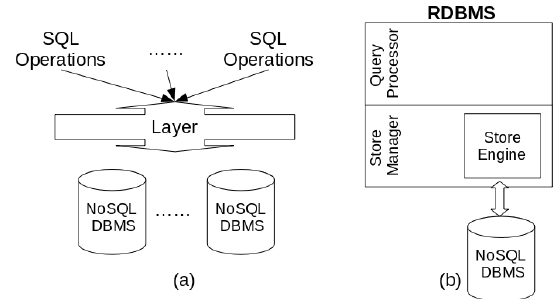
Figure 1. Overview of the proposed architectural classification for the related work.